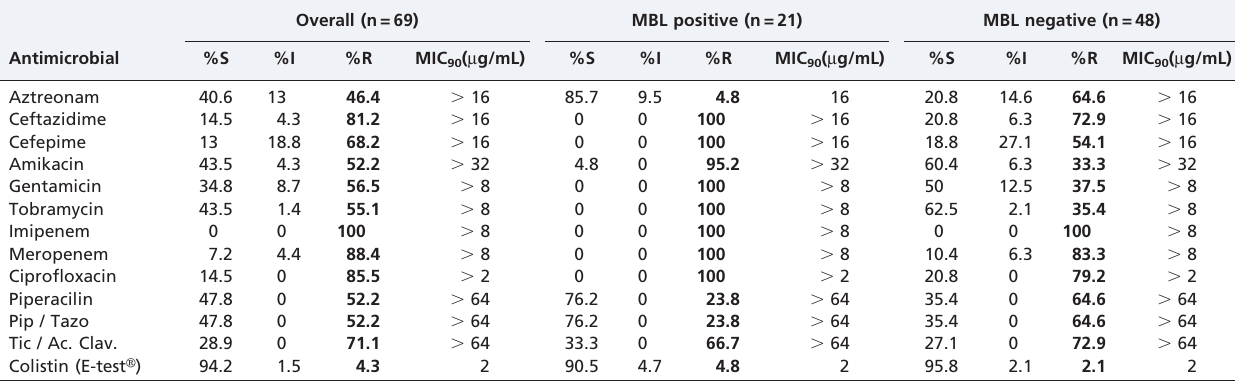
Table 3 - Susceptibility profile and MIC 90 of 69 IRPA samples and the analysis according to MBL production. Overall (n=69) MBL positive (n=21) MBL negative (n=48)